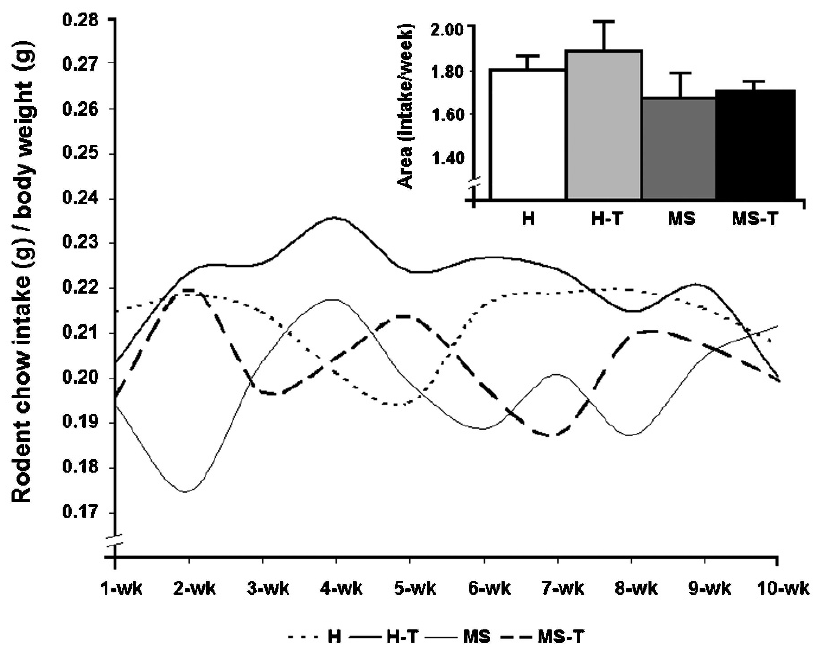
Figure 1 - Smooth curve of relative food intake (chow [g]/body weight [g]). H (n=5): sedentary spontaneously hypertensive rats; H-T (n=5): trained spontaneously hypertensive rats; MS (n=5): sedentary metabolic syndrome rats; MS-T (n=5): trained metabolic syndrome rats. The detailed view shows the area under the curve (AUC). One-way ANOVA was used to compare the AUCs. There were no differences in food intake between the groups ( p . 0.05).